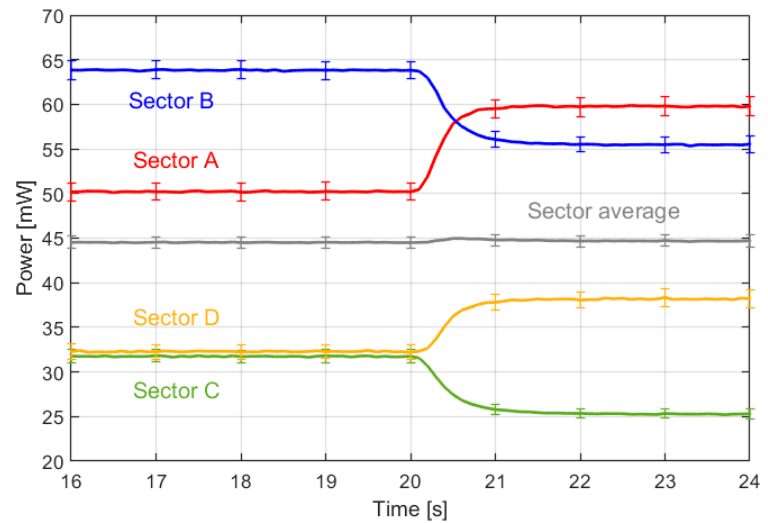
Figure 15. Response time, in the range 0.5–1 s, of the power delivered to the four sensor sectors after a sudden change of the yaw angle (e.g., the wind direction) at t = 20 s. The grey curve is the average power delivered to the four sectors. In order to reduce noise, the curves have been averaged from the results of 250 repeated transients. The 1 σ error bars of the measurements are also shown. The measurement was made at the UPC wind tunnel, using the sensor with the grooves covered, as in the experiments of Section 5. The sectors (A, B, C and D) follow the same disposition as the one shown in Figure 13a or Figure 11